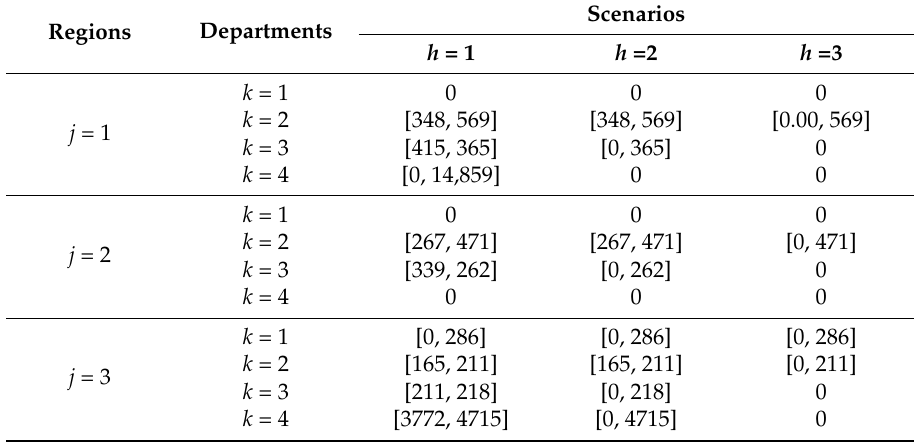
Table 6. Water resource deficit for each sector under different scenarios in Period 3 (10 4 m 3 /year).